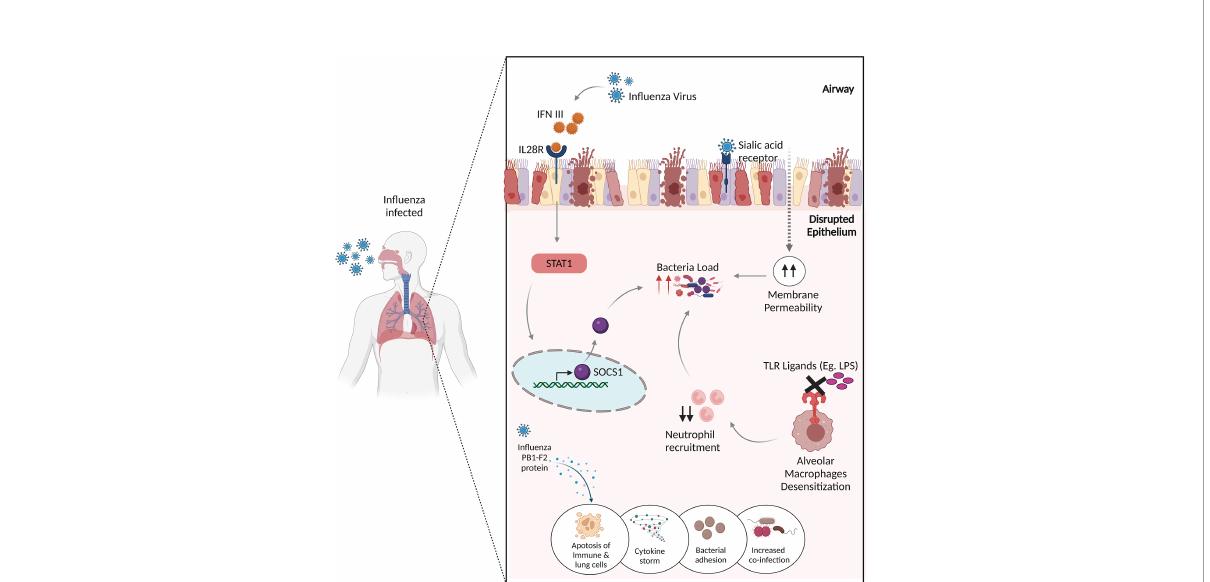
FIGURE 2 Potential mechanisms of in fl uenza virus infection and bacterial co-infections. The in fl uenza virus produces IFN III, which stimulates STAT1, which then activates SOCS1 to regulate antimicrobial peptides, resulting in enhanced co-infection. The binding of in fl uenza virus to sialic acid receptors causes lung epithelial damage, increasing membrane permeability to bacterial infections. Desensitization of alveolar macrophages to TLR ligands prevents the immune system from recruiting appropriate neutrophils, resulting in increased bacterial burden. The in fl uenza virus ’ s non-structural PB1-F2 protein increases in fl ammatory responses to co-pathogens by inducing apoptosis in immunological and lung epithelial